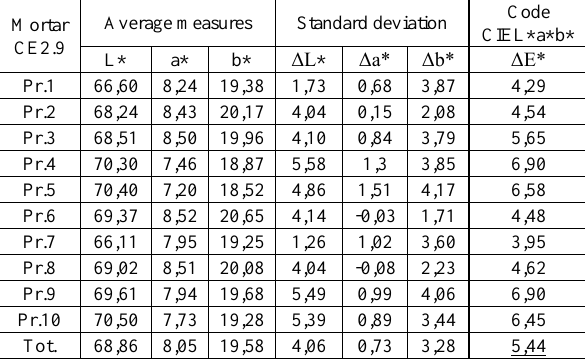
Table 8. CE2.9 Standard deviation from sample taken at Ceresole d’Alba. Produced by the